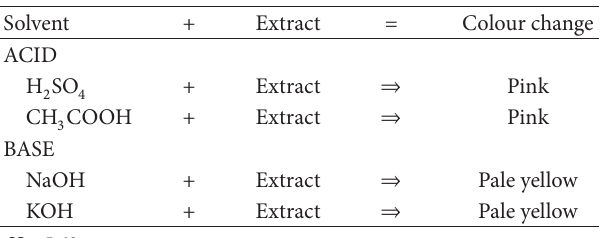
Table 7: Rose extract (methanol extract) (initial color of extract, red).